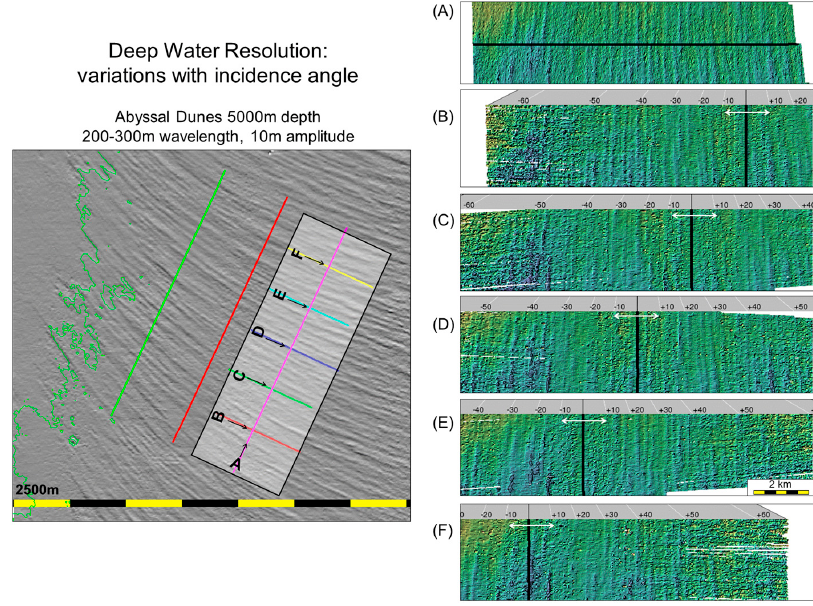
Figure 5. Illustrating the identical seafloor as imaged by the same multibeam sonar with different offsets. The seafloor consists of a field of abyssal dunes in 5000 m of water. The dune spacing (~5% of depth) and amplitude (0.2% of depth) is close to the limit of the system resolution (an EM122 1° × 1°). Left: Regional map showing location and orientation of acquired survey lines. ( A ) Shows an optimal bathymetric rendition acquired with a reduced swath width of ±25° with the ship-track oriented orthogonal to the dune crests; ( B – F ) shows the same area with 5 survey lines using ±65°, each of which is offset 2 km from the next. The same specific dunes are thus observed at 5 different grazing angles while progressing from amplitude to phase detects (and switching to FM pulses at 35°). The white arrowed section indicated the amplitude detection zone.